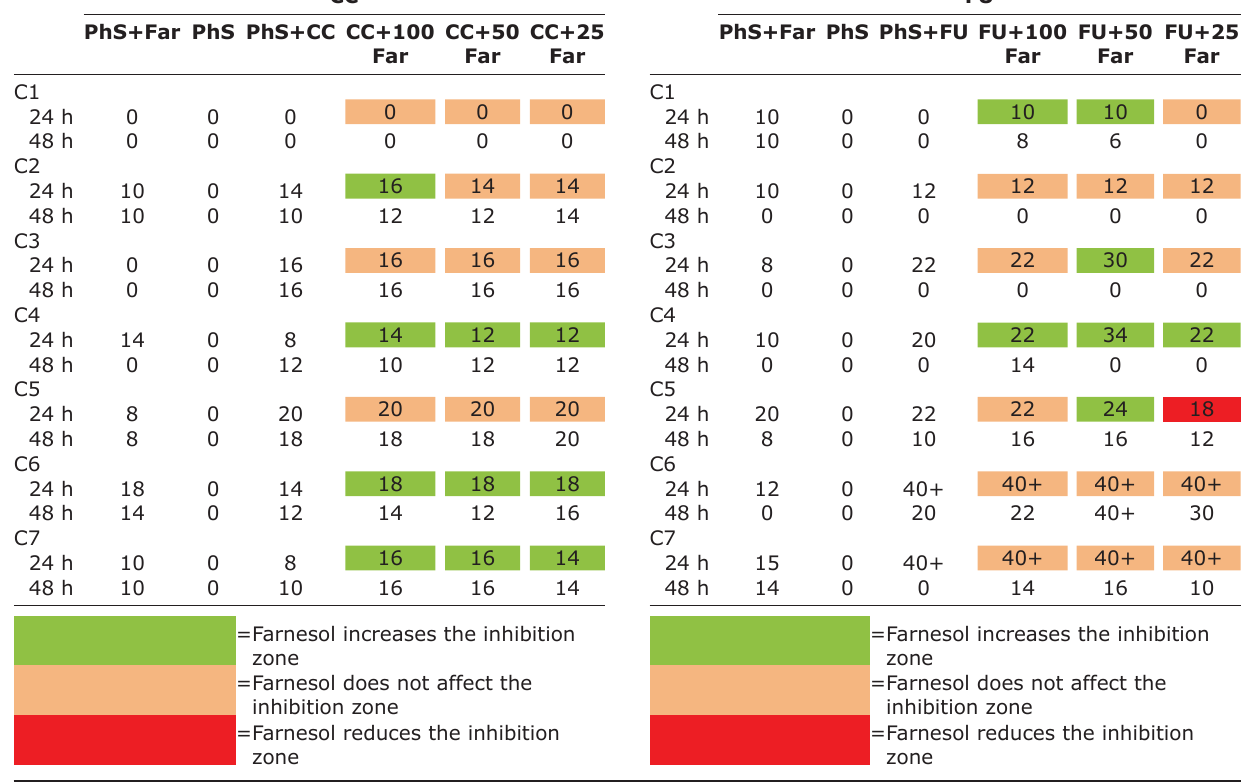
Table-6: Fluconazole sensitivity determination of 7 Candida albicans strains and the effect of farnesol three concentrations on these